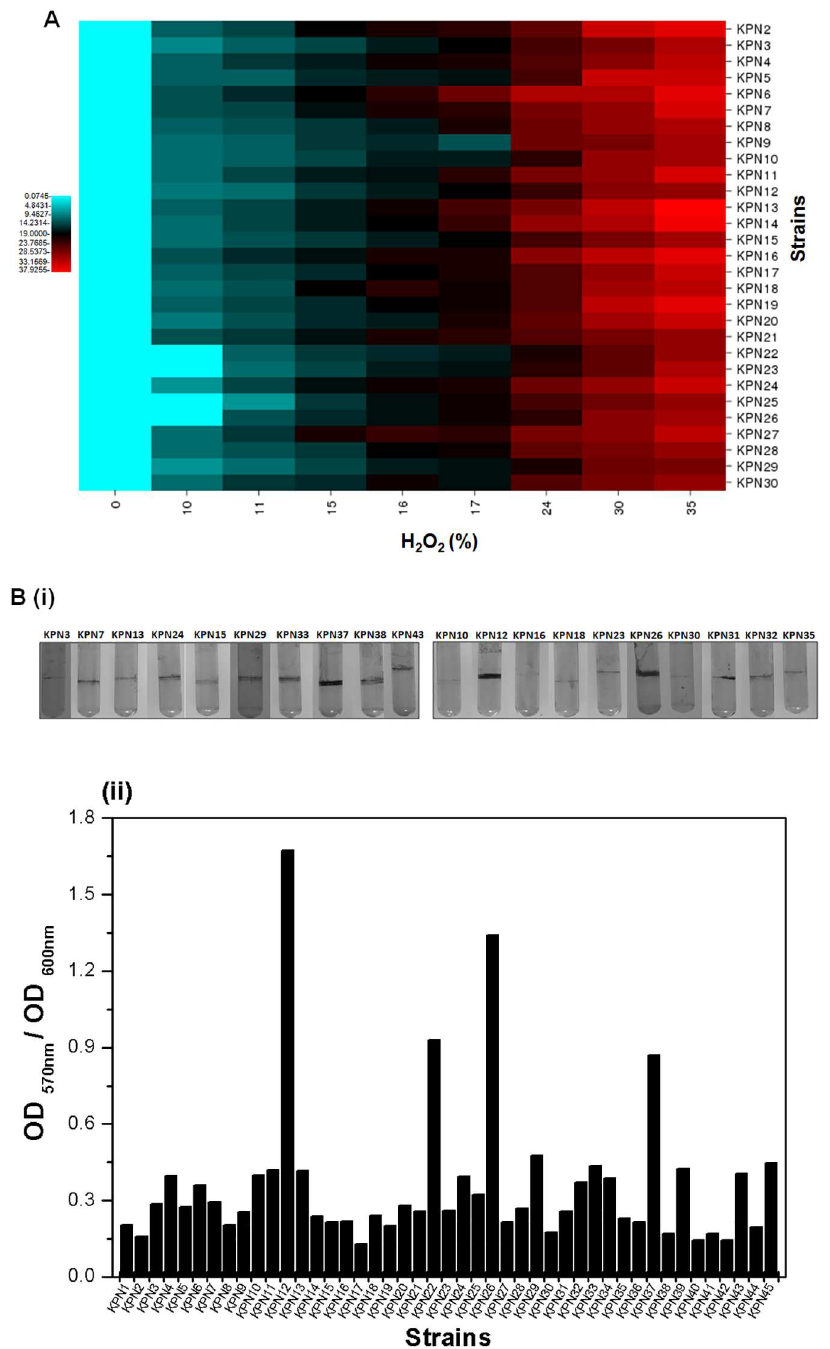
Fig 6. Oxidative stressand bioflim formating assayin K . pneumoniae strains. (A) Diagramshowingthe zone of inhibitionin different strains due to the different concentration of H 2 O 2 . In this study 0%, 0.1%, 1%, 3%, and 10% of H 2 O 2 were used as oxidativestress inducingagent. The diagramrepresentsthe mean of three independent experiments. (B) Biofilm formation by the K . pneumoniae isolates are shown here: i) tubes showingstainedbiofilm rings in few representative isolates ii) graphicalpresentation of biofilm formation amongthe isolates is shown as the ratio of OD 570nm and OD 600nm . The bar graph representsthe mean of three independent